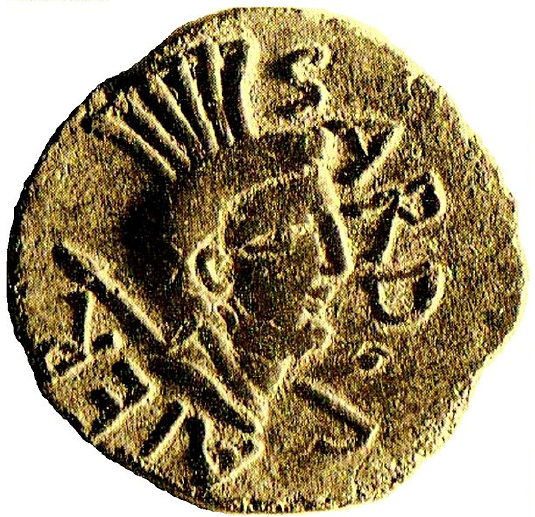
Figure 8. Coin found depicting Sardus Pater (‘Coin Sardus Pater Babai’ by Shardan 2010/Wikimedia Commons is released under CC BY-SA 3.0).